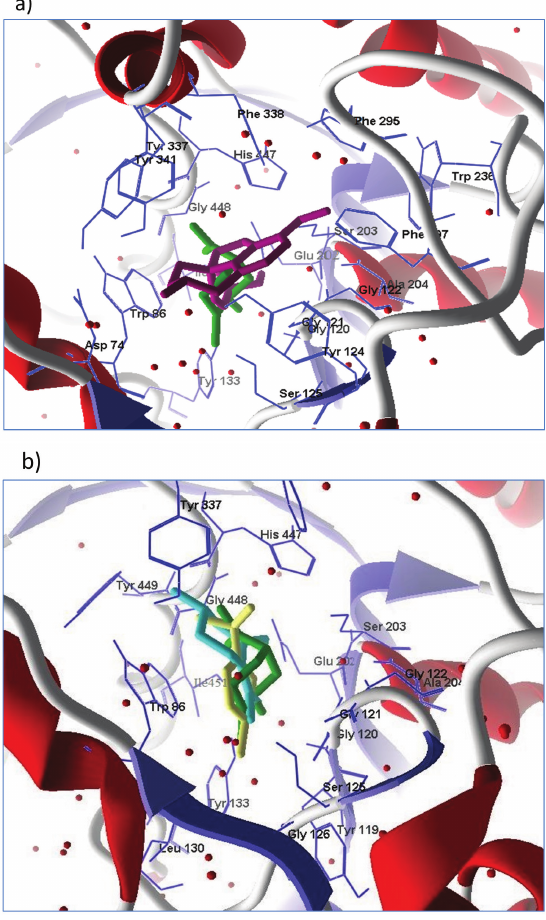
Figure 3: Results of molecular docking for the most active terpenes and galantamine, a reference molecule. (a) Comparison of carvone (green) and galantamine (magenta) bind to AChE active site, (b) docking results obtained for the most active AChE inhibitors: carvone (green), pulegone (blue) and γ -terpinene